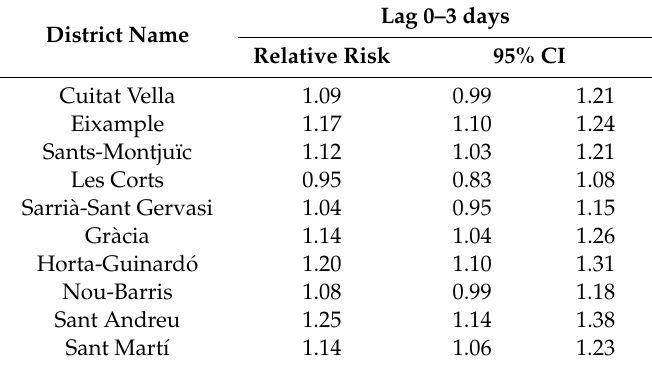
Table 4. Relative risk of all-cause mortality related to summer extreme temperatures by district during the study period 1992–2015 in